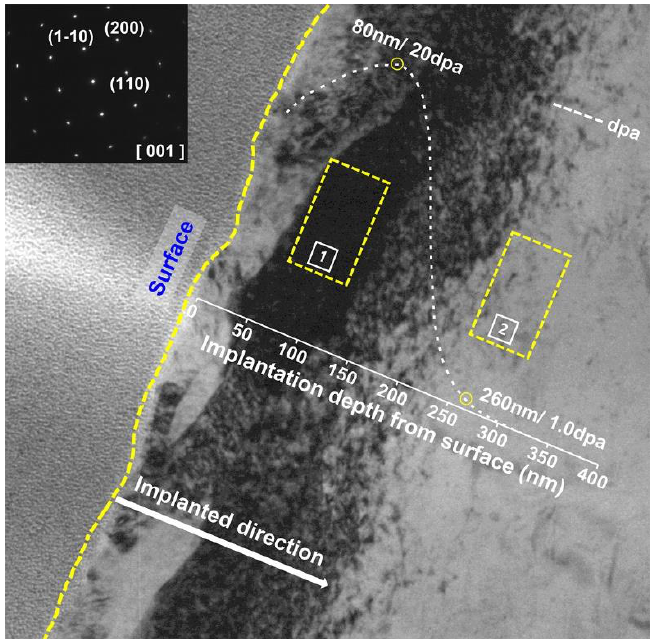
Figure 6. TEM images of the damage regions for the specimen irradiated with 400 keV Fe-ions to 1.27 × 10 16 Fe cm − 2 overlaid with the predicted dpa profile by SRIM. Region 1 in the figure is a high damage region and region 2 is a low damage region. The insert figure in the upper left corner is diffraction pattern of matrix.